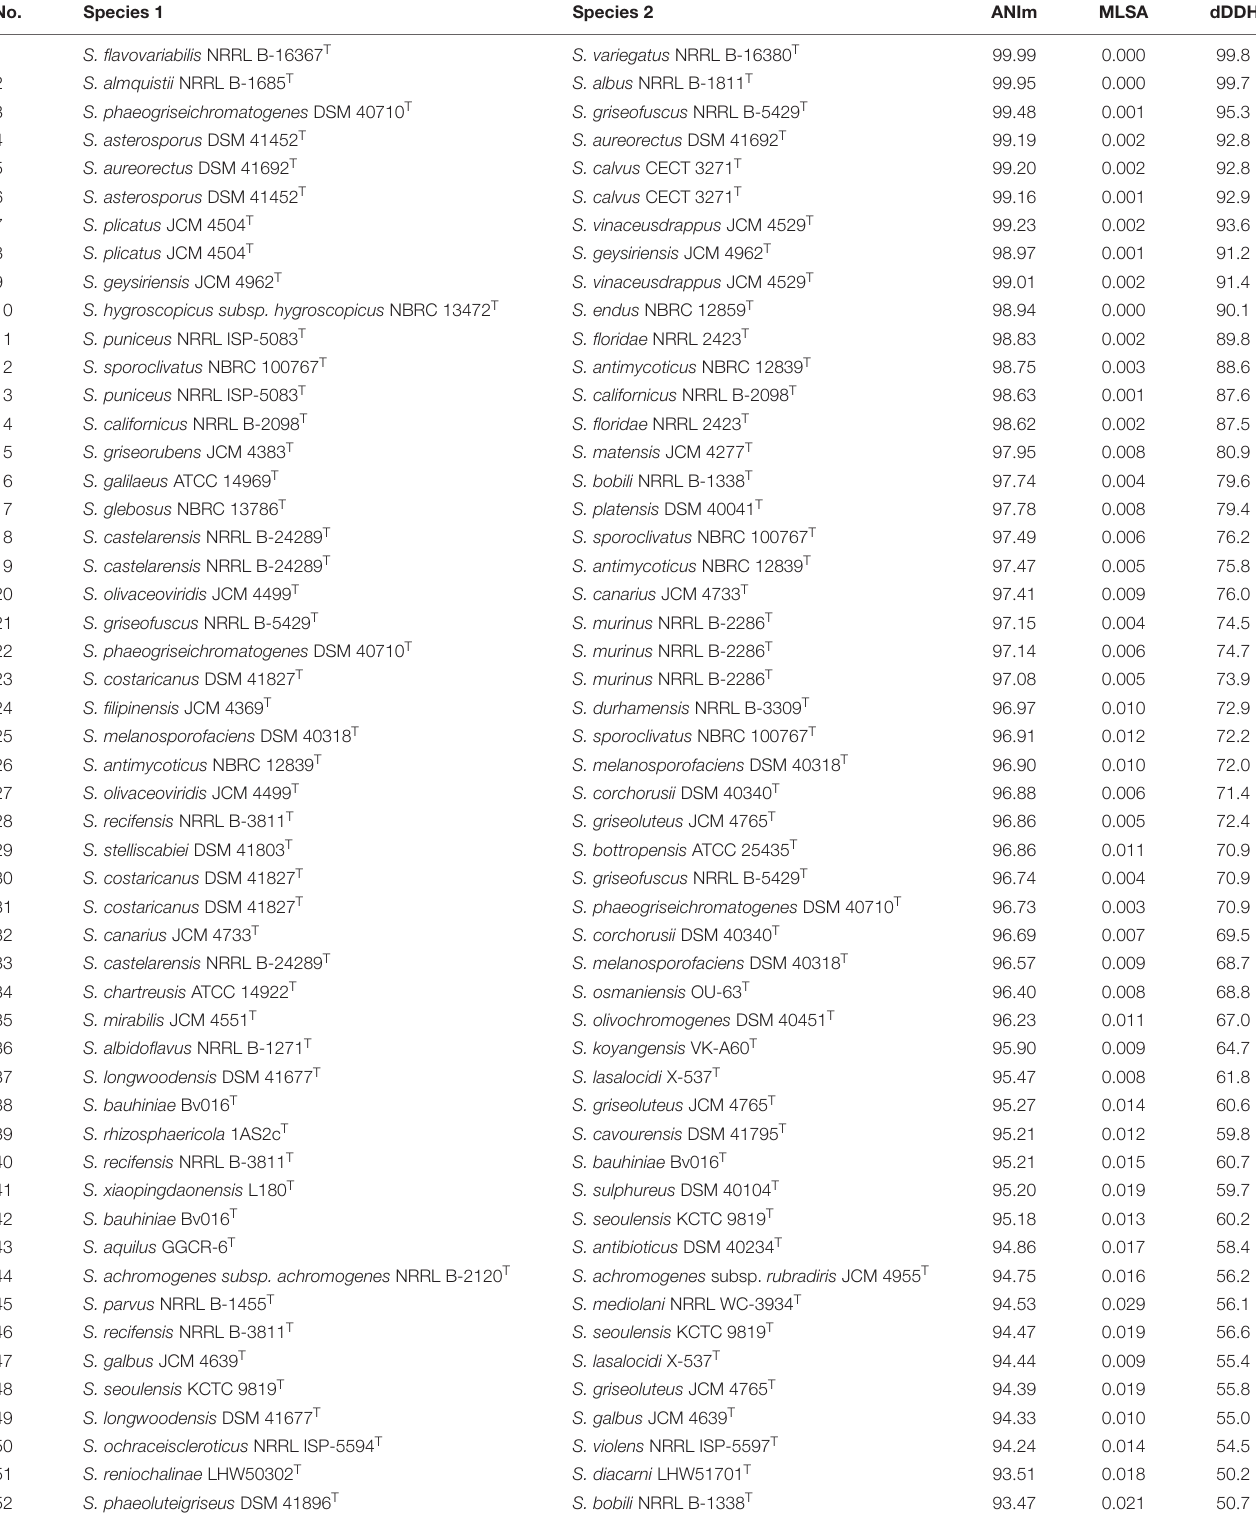
TABLE 1 | ANIm, MLSA, and dDDH values among 78 pairs of type Streptomyces species including heterotypic synonyms. No. Species